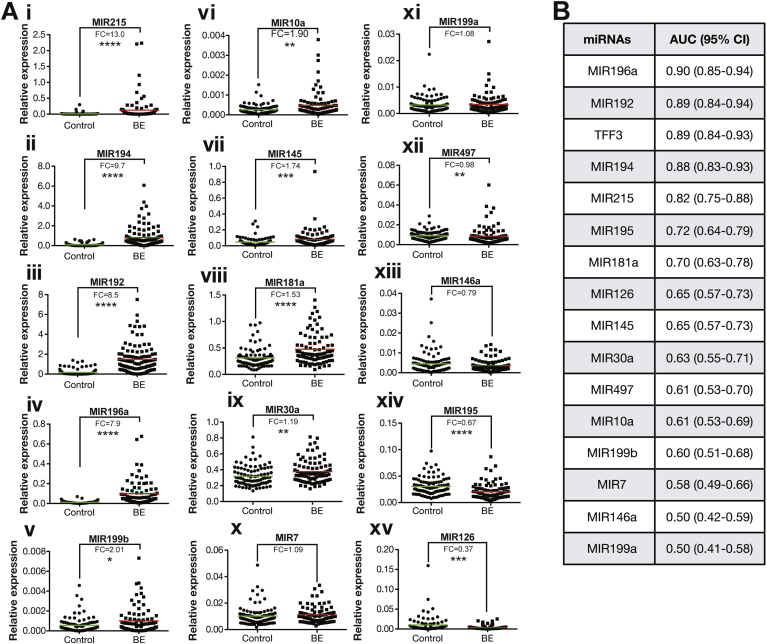
Validation of up-regulated miRNAs in case-control Cytosponge sample set. (A i–xv) Relative miRNA expression determined by qPCR Fold changes (FC) and mean (colored line) are presented for each miRNA. Significance determined by Mann-Whitney test: *P < .05; **P < .01; ***P < .001; ****P < .0001. (B) AUC and 95% CI for each miRNA and TFF3 were calculated using validation qPCR results.